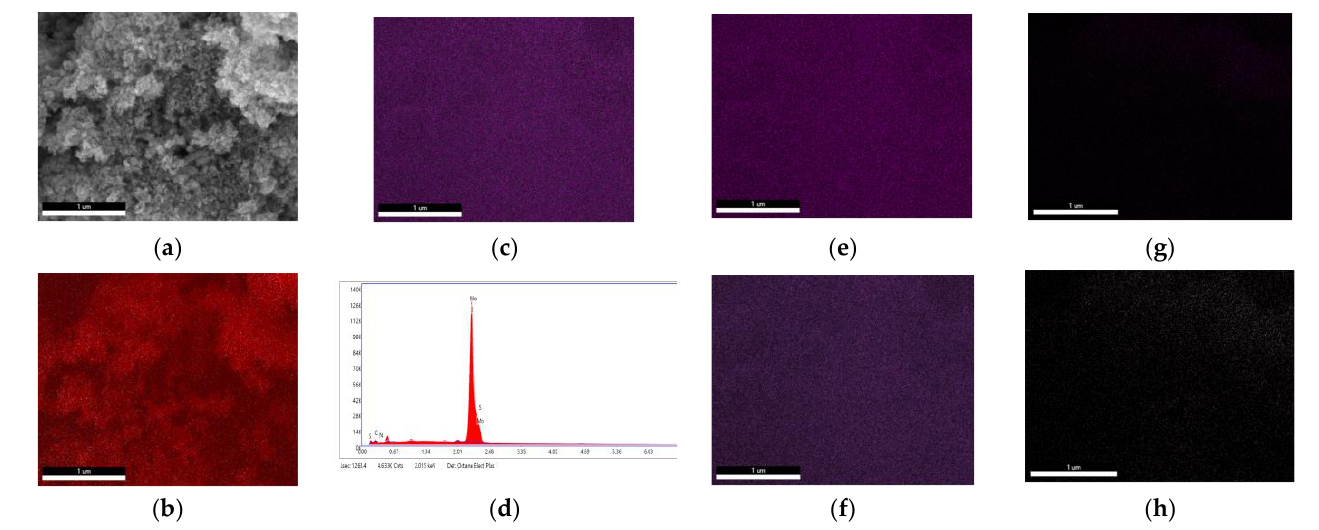
posite, as seen in Figure 10.